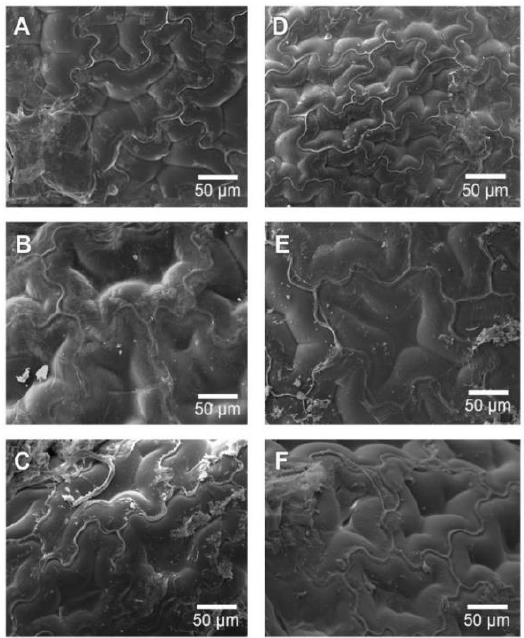
Figure 5. Microstructure of the dried Physalis purée seeds via SEM (200× ). Non-assisted RW™ method at 60 ◦ C ( A ), 75 ◦ C ( B ), and 90 ◦ C ( C ). IR-assisted RW ™ method 60 ◦ C ( D ), 75 ◦ C ( E ), and 90 ◦ C ( F ). at 60 °C ( A ), 75 °C ( B ), and 90 °C ( C ). IR-assisted RW™ method 60 °C ( D ), 75 °C ( E ), and 90 °C ( F ).